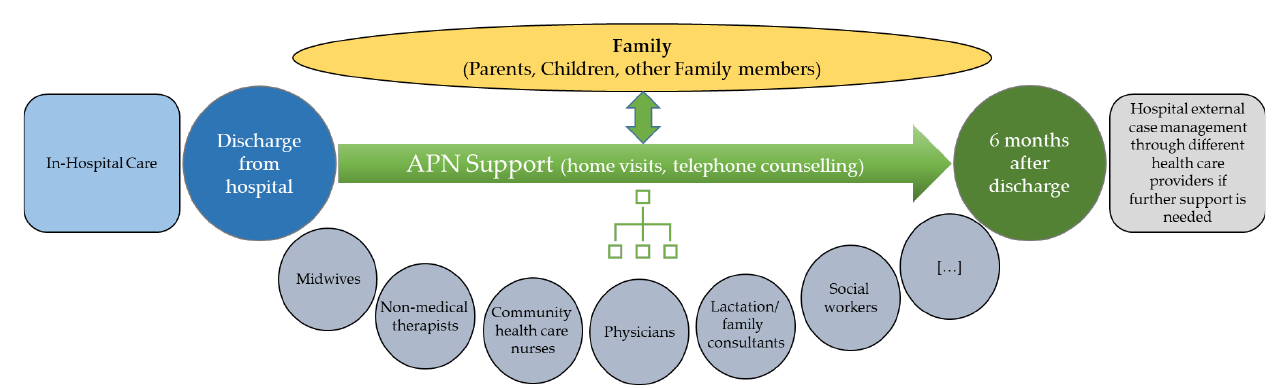
Figure 1. Timeline and involvement of the different professions in the “Transition to Home (TtH) ” model. (TtH)”